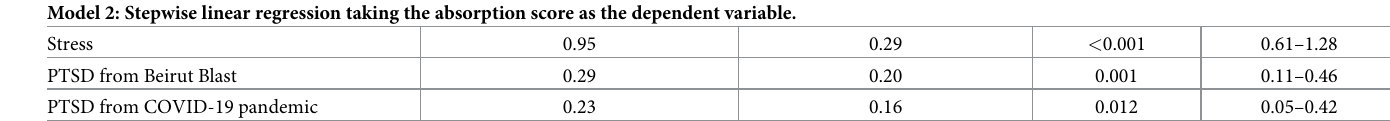
Variables entered in the model: PTSD from Beirut Blast, Stress (BDS score), PTSD from economic crisis, Personal history of PTSD, Personal history of anxiety disorder, Personal history of depression, Depression (PHQ9 score), Anxiety (LAS score), PTSD from COVID-19 pandemic, PTSD from Beirut Blast; PTSD = Post traumatic stress disorder. Nagelkerke R 2 = 34.4%. Model 2: Stepwise linear regression taking the absorption score as the dependent variable.